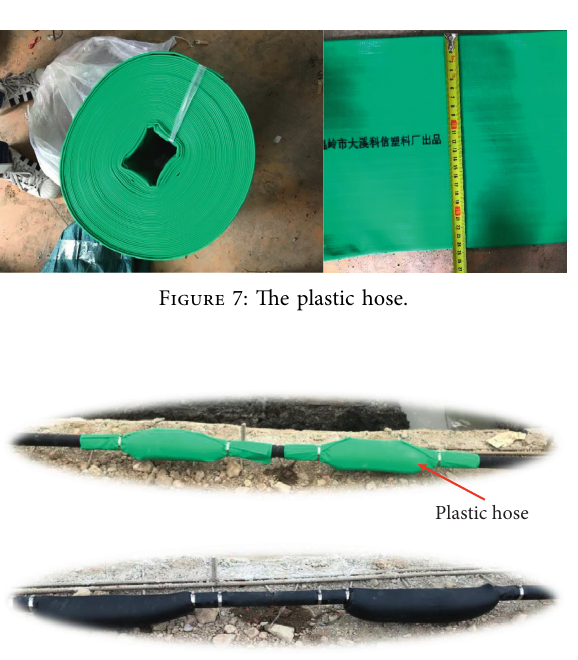
Figure 8: The expanding effect of the airbags with plastic hose.